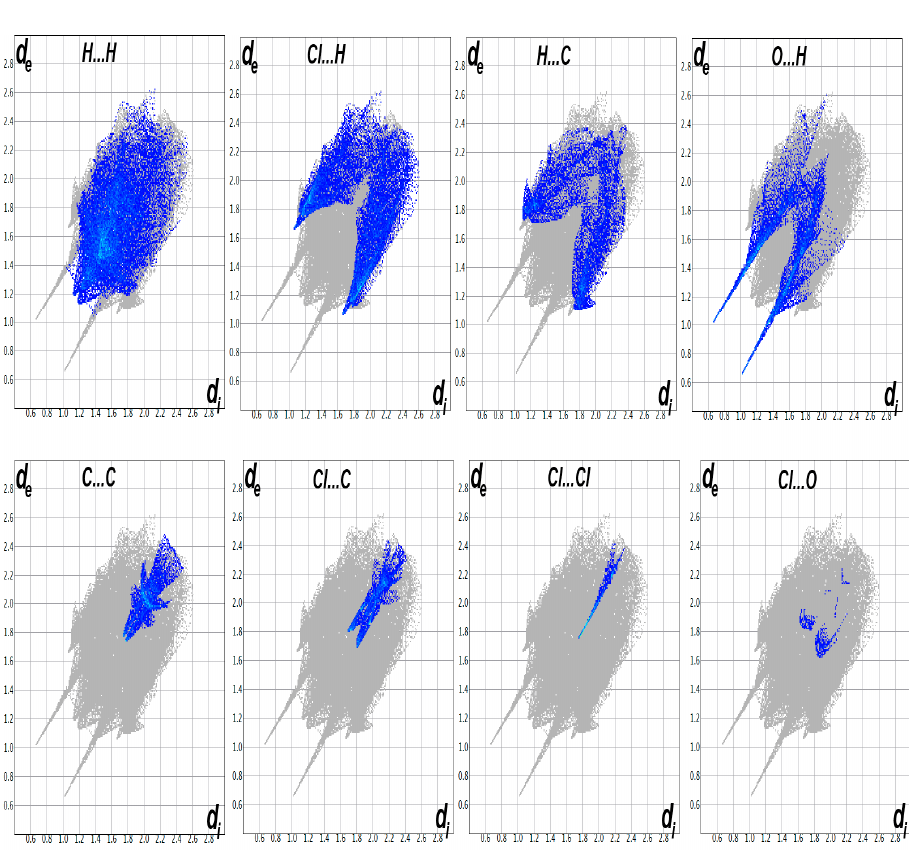
Figure 3. Hirshfeld surfaces of 5 .